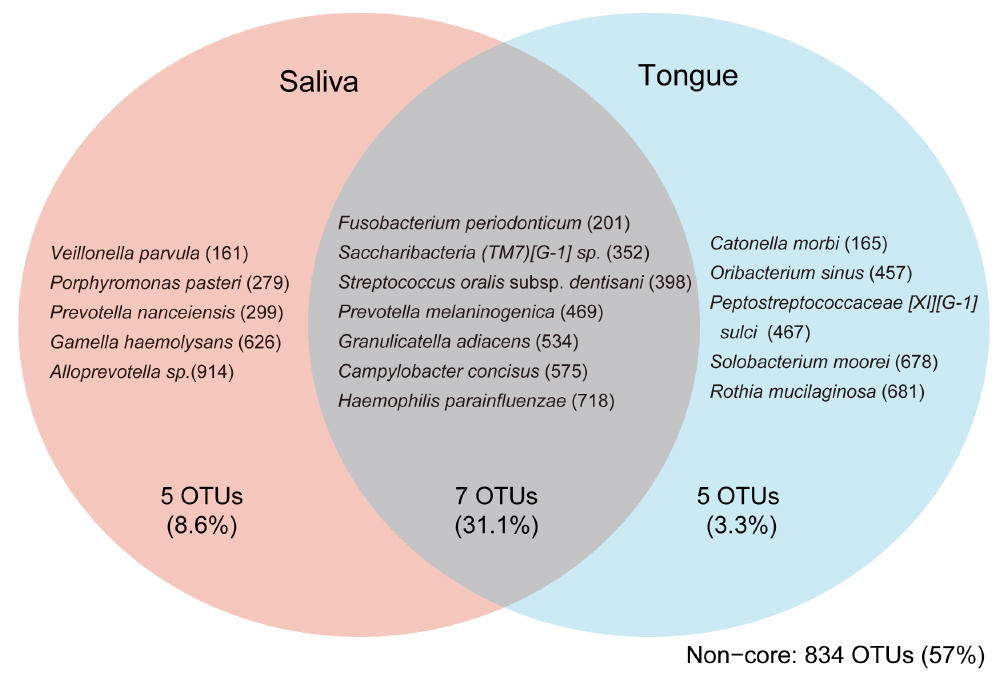
Figure 5. Venn diagram of the core oral operational taxonomic units (OTUs). OTUs present in ≥ 95% of samples (D1 samples, n = 58) in the indicated subset of oral sites are shown together with the average total abundance of the OTUs in the group. For example, Veillonella parvula was found in ≥ 95% of saliva samples and <95% of tongue samples. Taxon IDs in eHOMD are indicated in the